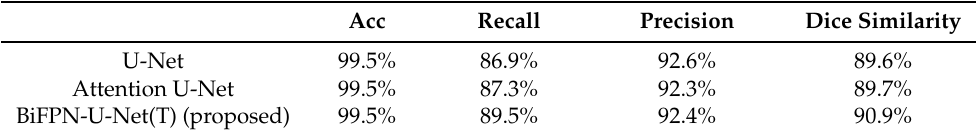
Table 1. Comparison of the pixel detection performance among models.